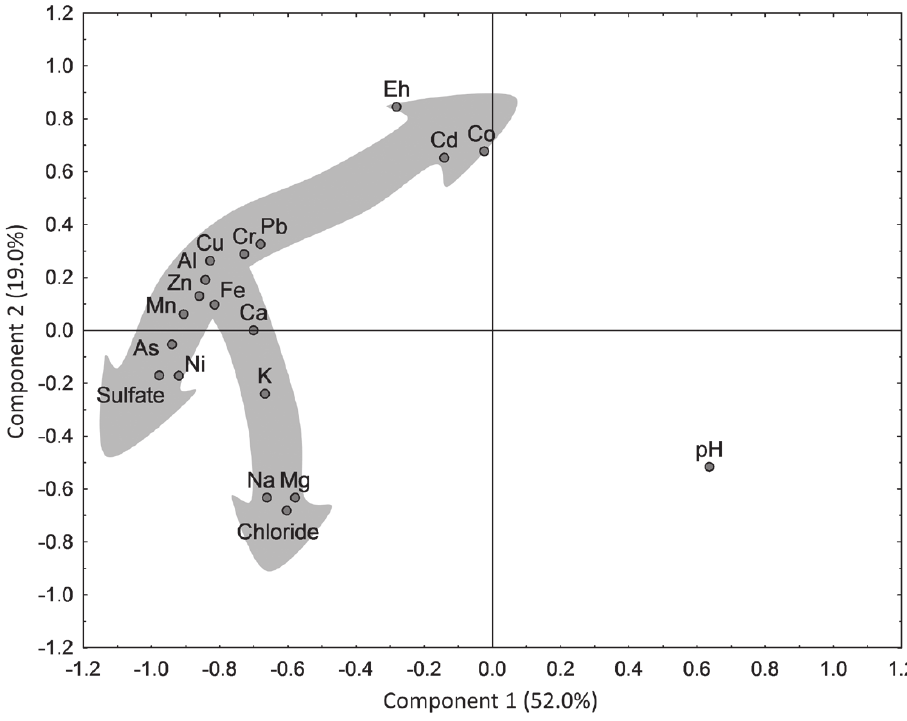
Figure 3 - PCA components 1 and 2 for surface and ground water data. Shaded arrows represent main association trends followed by major and trace elements (see